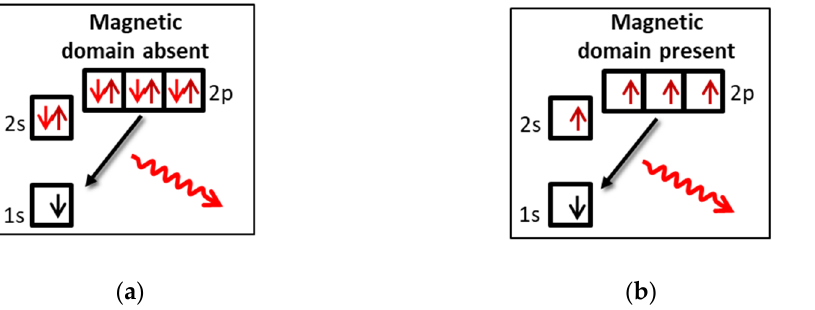
Figure 1. Radiative Deexcitation ( a ) in the absence of magnetic domains with a fully occupied L-shell and ( b ) in the presence of magnetic domains with a half occupied L ‐ shell.